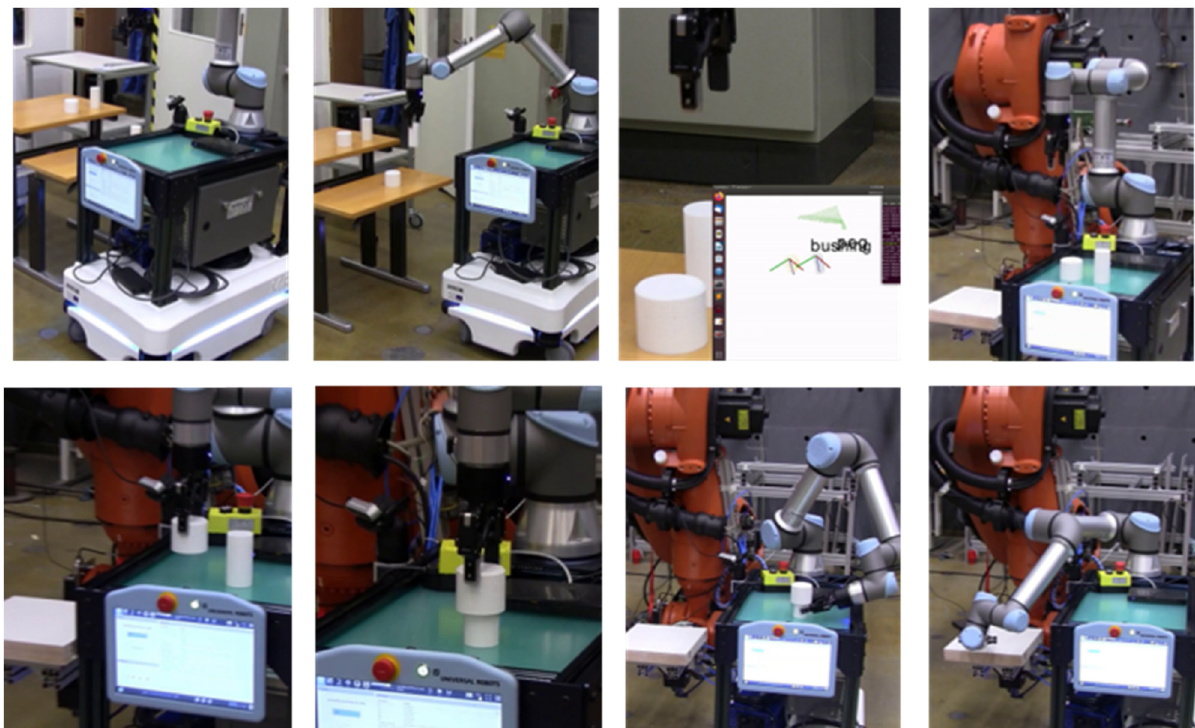
Figure 13: Indoor parts logistics: transportation and assembly operations guided with on - board 3D vision.